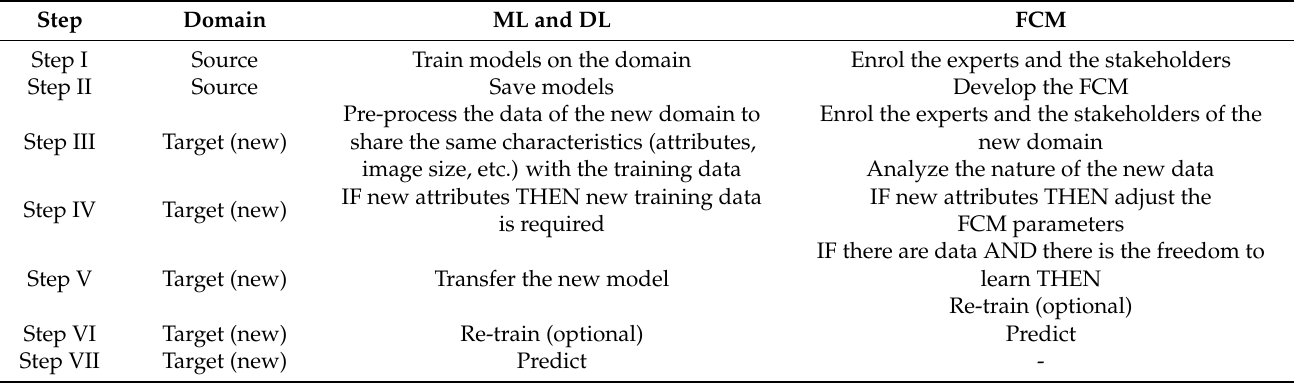
Table 2. Step for transferring AI models from the initial domain to a new